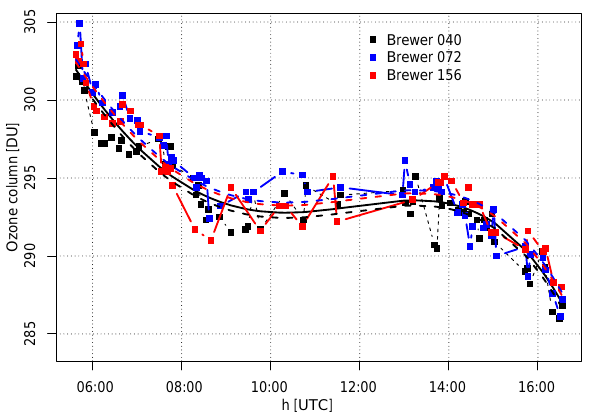
Figure 5. Diurnal variability of the Brewer triad for 12 July 2011: ozone column vs. time [UTC]. The continuous black line is the model diurnal variation and the dashed lines correspond to the model adjusted to each Brewer data set. The black, blue and red colors correspond to the B 040 , B 072 and B 156 Brewer